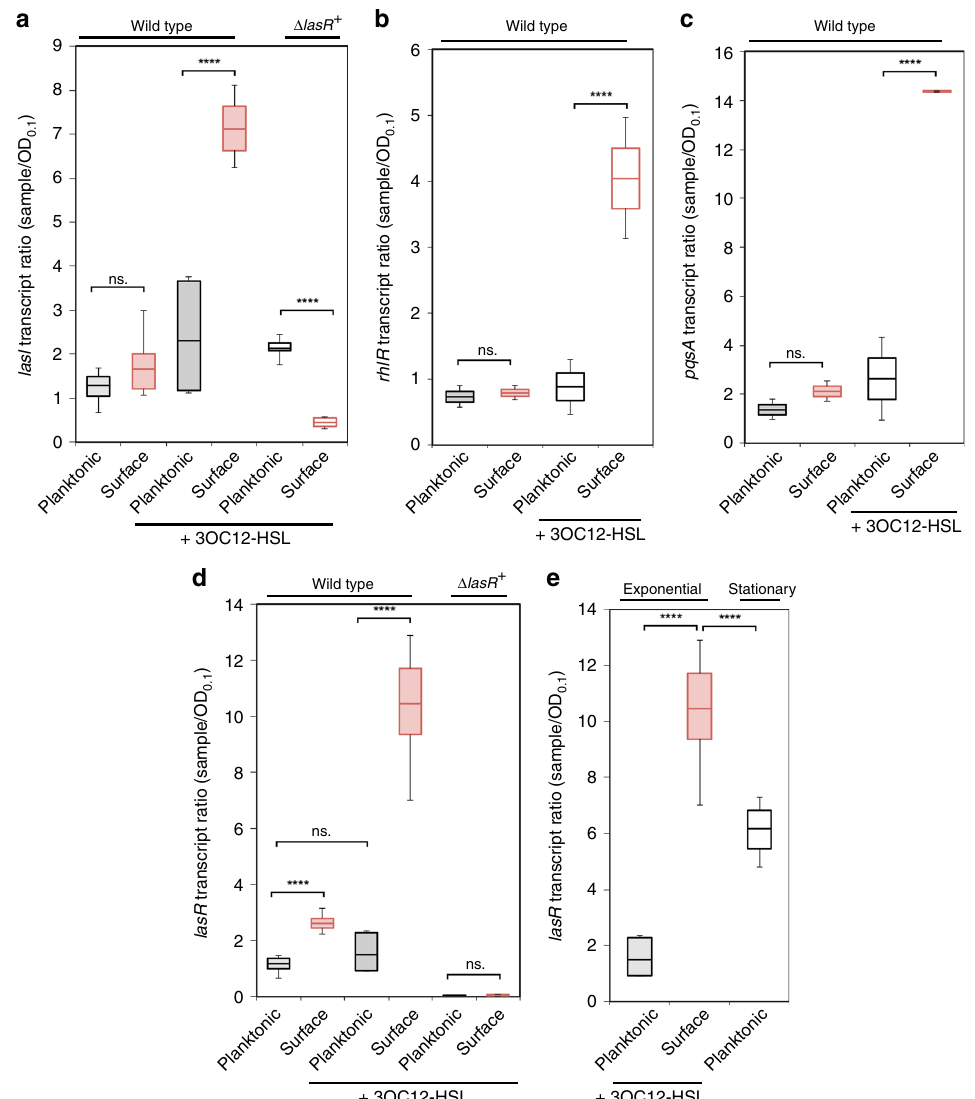
Fig. 2 Surface-association increases QS response. qRT-PCR levels normalized to OD and 5 S rRNA for lasI a , rhlR b , pqsA c , and lasR d expression after 1.5 h treatment with 3OC12-HSL or vehicle control. + ( Δ lasR mutant data collected after 3 h treatment due to decreased surface-attachment phenotype). e Expression of lasR in exponential phase compared to stationary phase by qRT-PCR. Error bars in plots represent standard deviation, and boxes indicate 25/75 data with the center representing the mean. A two tailed student ’ s t -test was performed to determine signi fi cance between samples and is denoted with asterisks ( n = 9) (ns. = no signi fi cance, * p < 0.01, **** p < 0.0001). Source data are provided as a Source Data fi